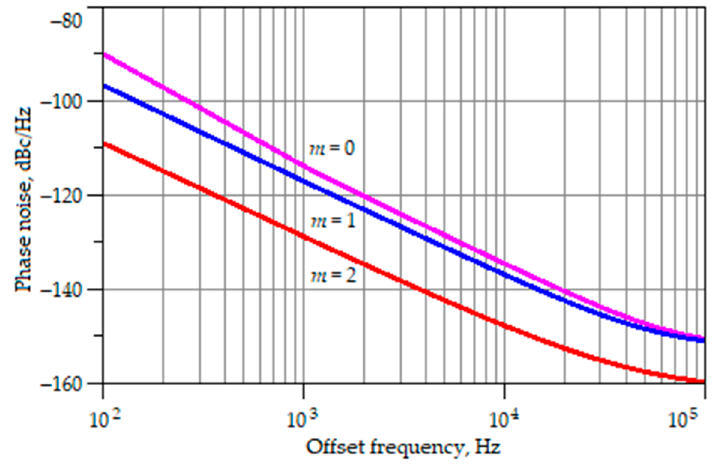
Figure 20. Phase noise versus offset frequency for the oscillator with multiple-output Wilson current mirror when R L = ∞ ; m = 0—purple curve, m = 1—blue curve, m = 2—red curve.